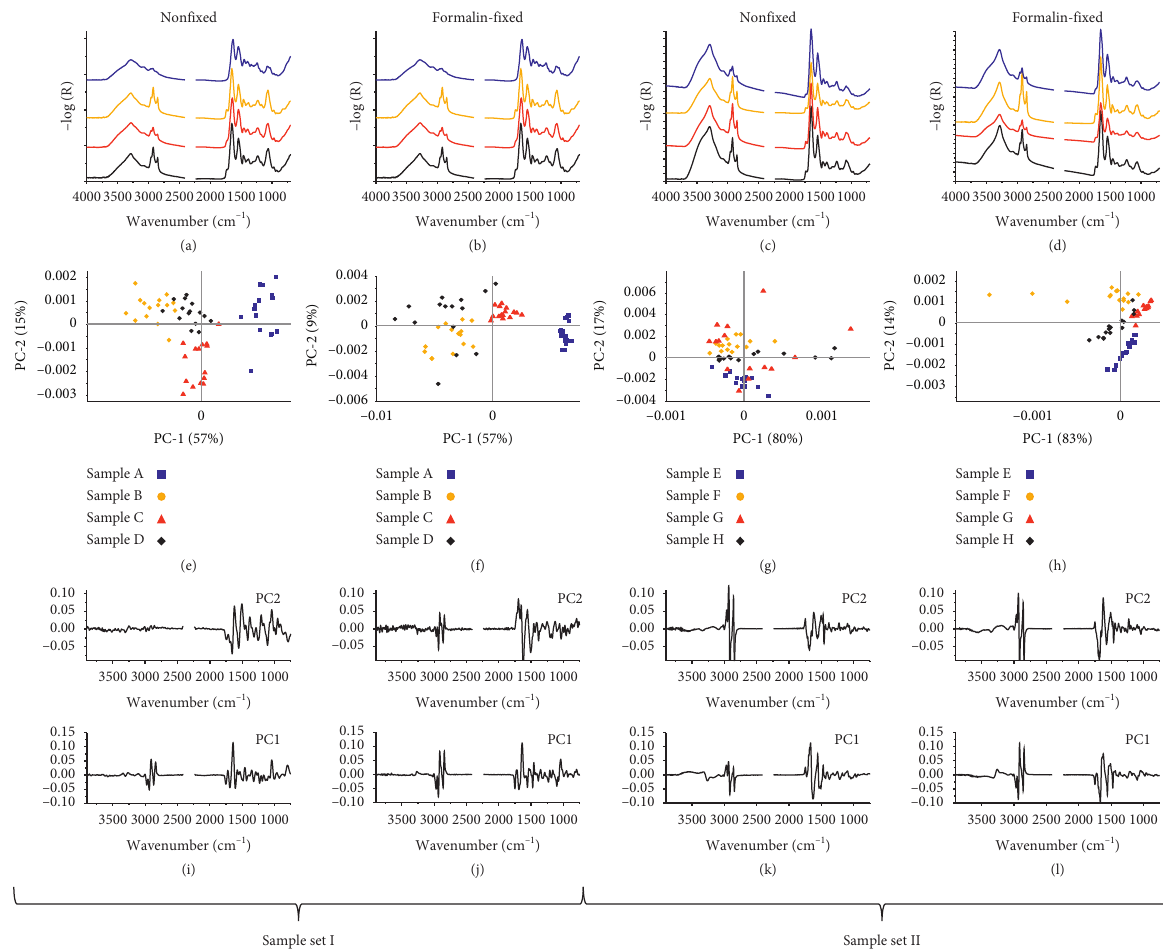
Figure 4: FTIR mean spectra and corresponding PCA models: FTIR mean spectra of nonfixed (a, c) and formalin-fixed (b, d) brain tumour tissue cross sections from 4000cm − 1 to 700cm − 1 . The wavenumbers of the CO 2 band between 2410cm − 1 and 2240cm − 1 were excluded. The spectra are vertically displaced and unit vector normalized. (e, g) Scores plot with PC1 versus PC2 to differentiate between nonfixed tissue samples. (f, h) Scores plot with PC1 versus PC2 to differentiate between formalin-fixed tissue samples. The representative tumour entities for the tissue samples A to D with different malignancies are fibrous meningioma (sample (A)), oligodendroglioma (sample (B)), anaplastic ependymoma (sample (C)), and glioblastoma (sample (D)). The representative tumour entities for the tissue samples E to H with different malignancies are plexus papilloma (sample (E)), oligodendroglioma (sample (F)), anaplastic oligodendroglioma (sample (G)), and glioblastoma (sample (H)). Corresponding loadings plots of PC1 (black) and PC2 (red) for nonfixed (i, k) and formalin-fixed (j, l) cross